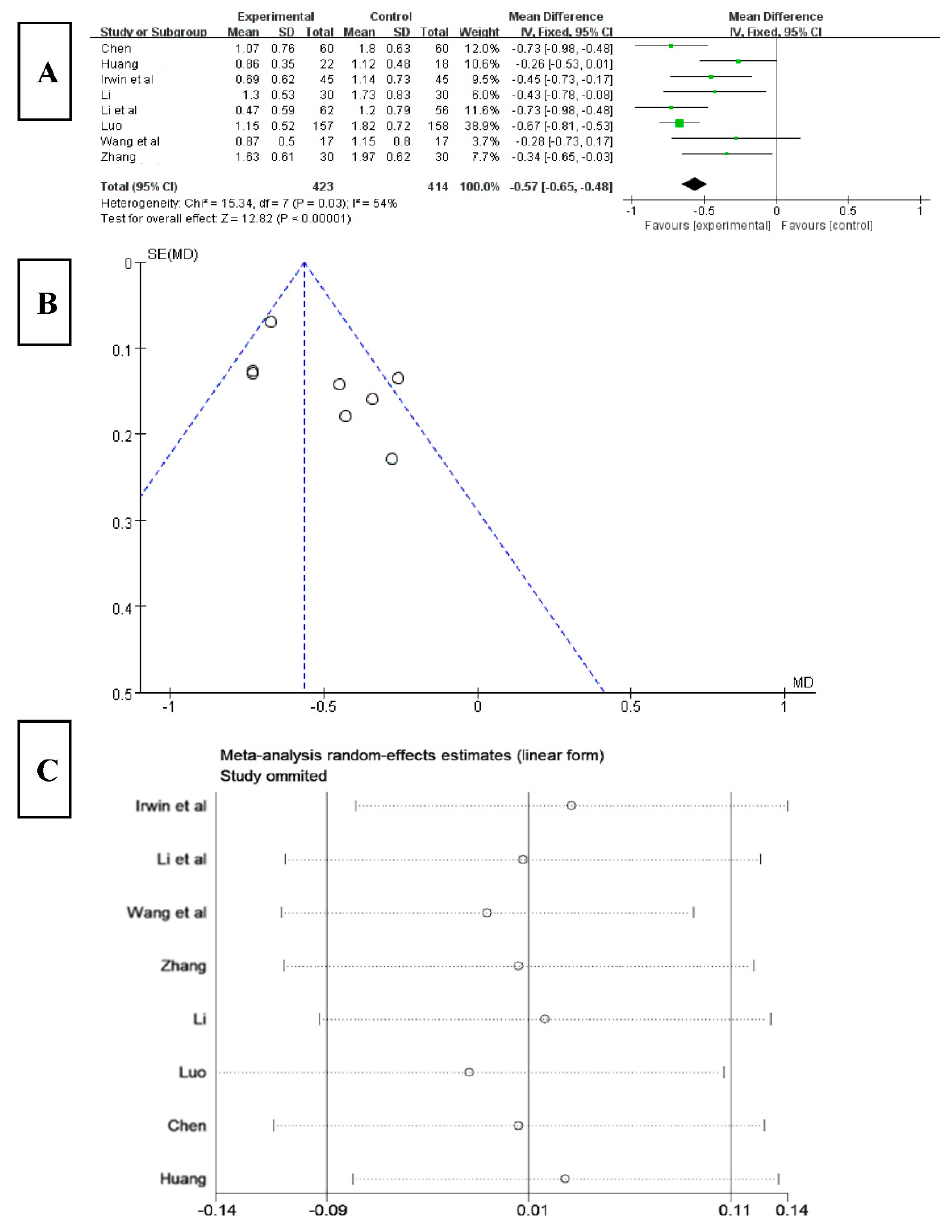
Figure 4. ( A ) Forest plot of sleep quality effect size. ( B ) Funnel diagram of sleep quality meta-anal- ysis. ( C ) Sensitivity analysis of sleep quality effect size. ( C ) Sensitivity analysis of sleep quality effect size